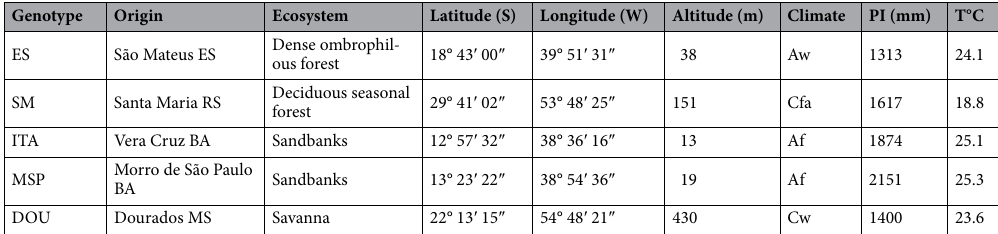
Table 1. Georeferences and climate information of native populations of S. terebinthifolia from five Brazilian ecosystems in the Atlantic Forest biome, used for population genetics and chemodiversity studies. BA, Bahia ; ES, Espírito Santo ; MS, Mato Grosso do Sul ; RS, Rio Grande do Sul ; PI, Pluviometric index ; Af, Tropical rainforest climate; Aw, Tropical wet and dry climate; Cfa, Subtropical fully humid hot summer; Cwa, Subtropical dry winter hot